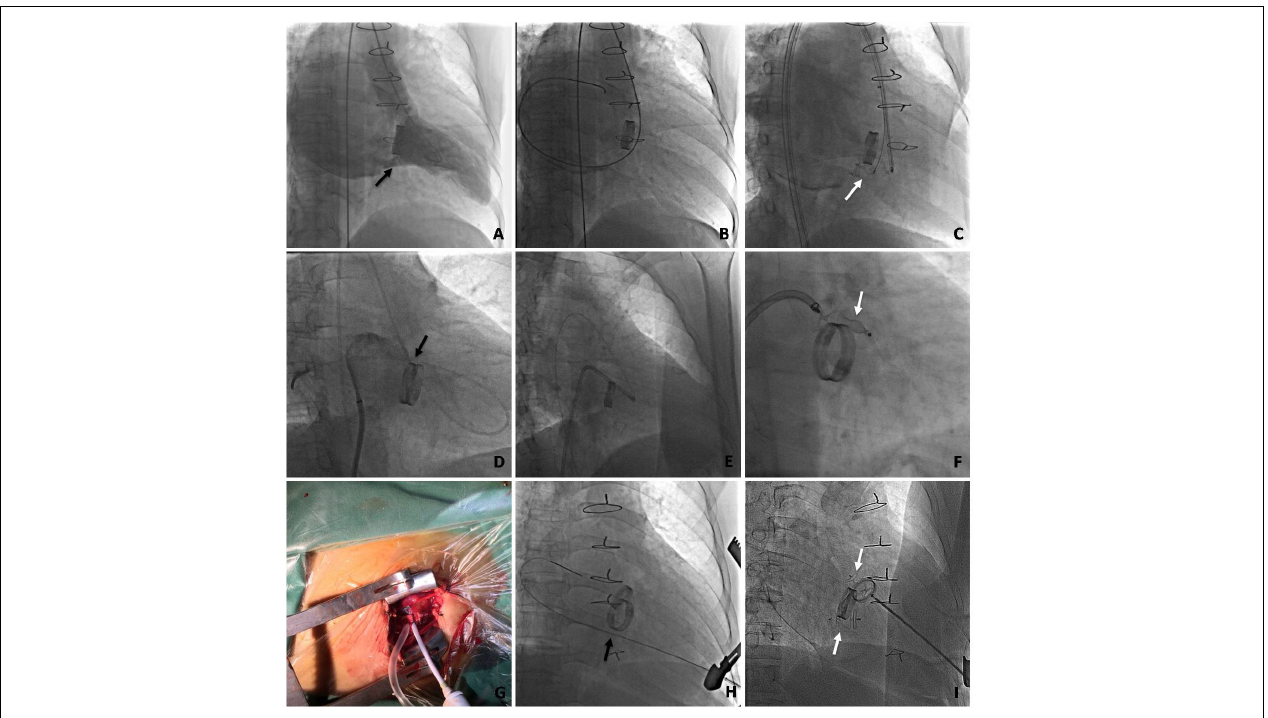
FIGURE 5 | Angiography during the transcatheter procedure of mitral mechanical PVL closure via multiple approaches. (A–C) Transfemoral retrograde approach. (A) Left ventricular angiogram to profile paramitral regurgitation. (B) Retrograde crossing of the PVL with the guidewire. (C) Occluder placed at the position of the PVL. (D–F) Arteriovenous wire loop approach. (D) The retrograde crossing of the PVL with the guidewire followed by a transseptal puncture. (E) The sheath is advanced into the left ventricle from the femoral vein via the arteriovenous wire loop. (F) An occluder is placed at the position of the PVL. (G–I) Mini-invasive transapical approach. (G) The transapical access is obtained with a 6 Fr sheath. (H) The mitral PVL crossed retrogradely with the guidewire. (I) The occluder is deployed. (The black arrow indicates the PVL. The white arrow indicates the occluder).